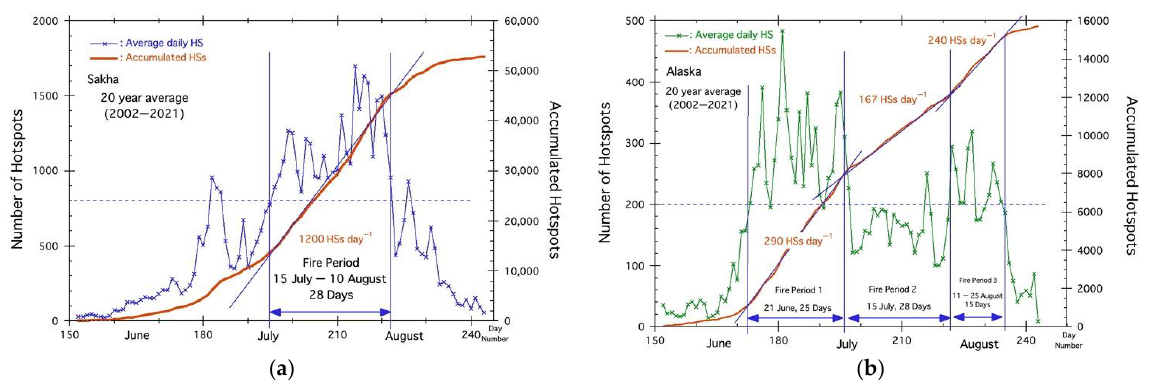
Figure 3. Average Fire Period. ( a ) Sakha, ( b ) Alaska.